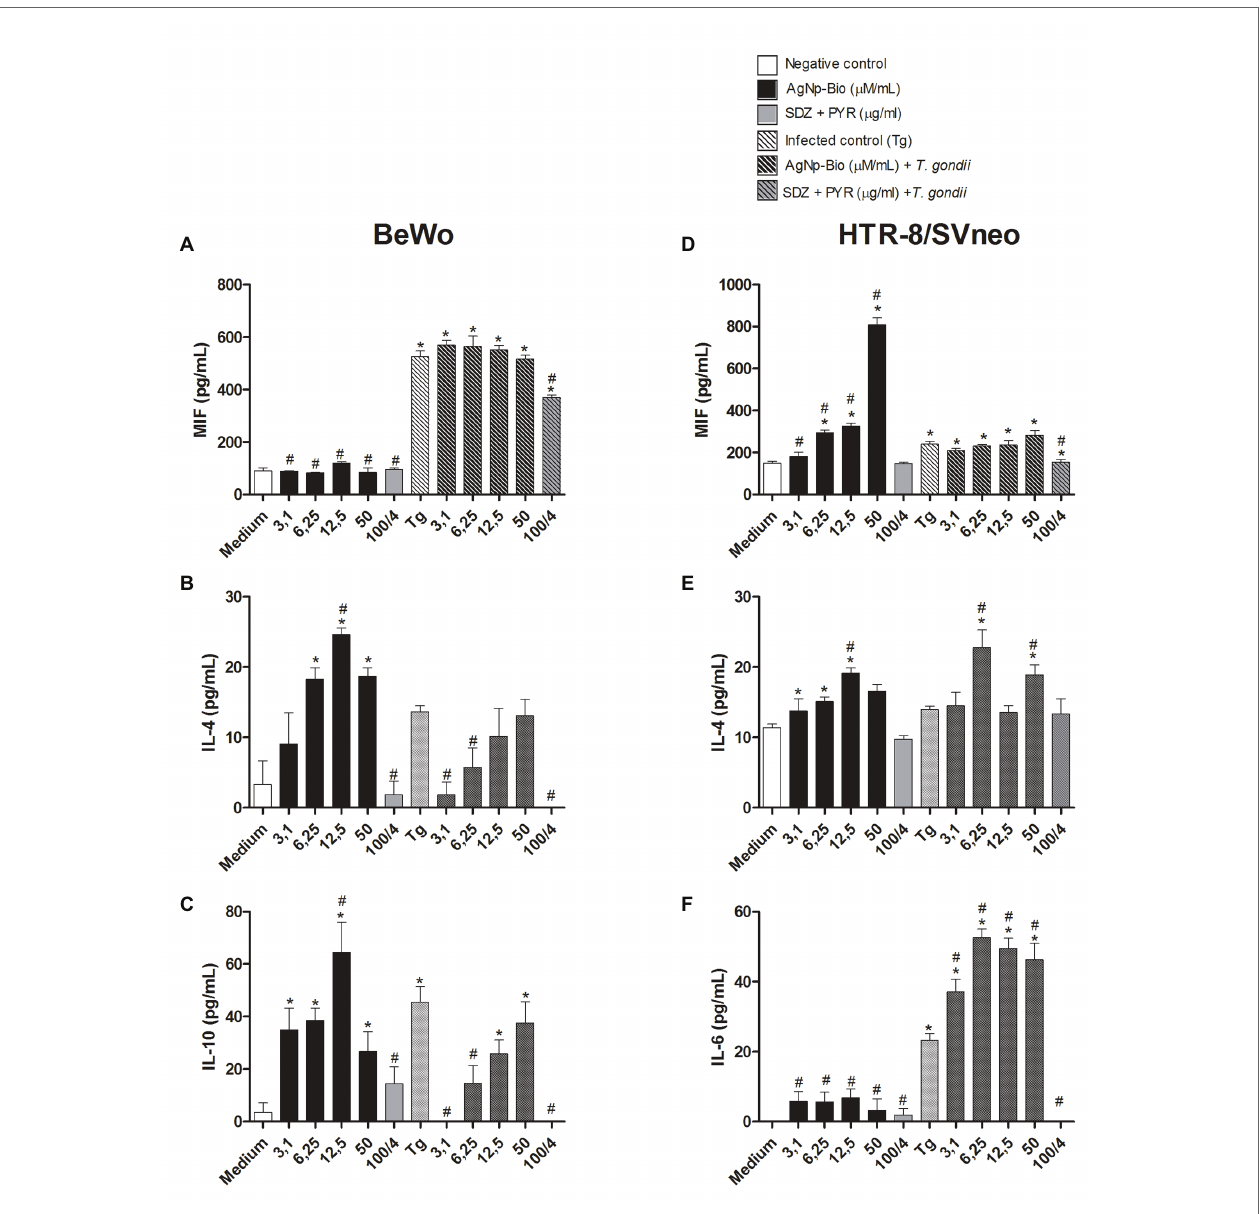
FIGURE 7 | Citokines production in BeWo and HTR-8 cells treated with different drugs and infected or not with Toxoplasma gondii (RH2F1 clone). BeWo and HTR-8/SVneo cells were cultured in plates for 24 h, infected or not with T. gondii (RH2F1 clone) for 3 h. After, cells were treated or untreated with different concentration of AgNp-Bio or combination of sulfadiazine/pyrimethamine (SDZ + PYR). Cell-free supernatants were collected after 24 h of treatment and the cytokines production was measured by sandwich ELISA. Production of macrophage migration inhibitory factor (MIF; A ), IL-4 (B) and IL-10 (C) by BeWo and production of MIF (D) , IL-4 (E) , IL-6 (F) by HTR-8/SVneo. Data were expressed in pg/ml and shown as mean ± SEM from three independents experiments in nine replicates. Comparison in relation to control (control; * p < 0.05). Comparison in relation to Tg ( # p < 0.05). Differences between groups were analyzed by One-Way ANOVA with the Bonferroni multiple comparison post hoc